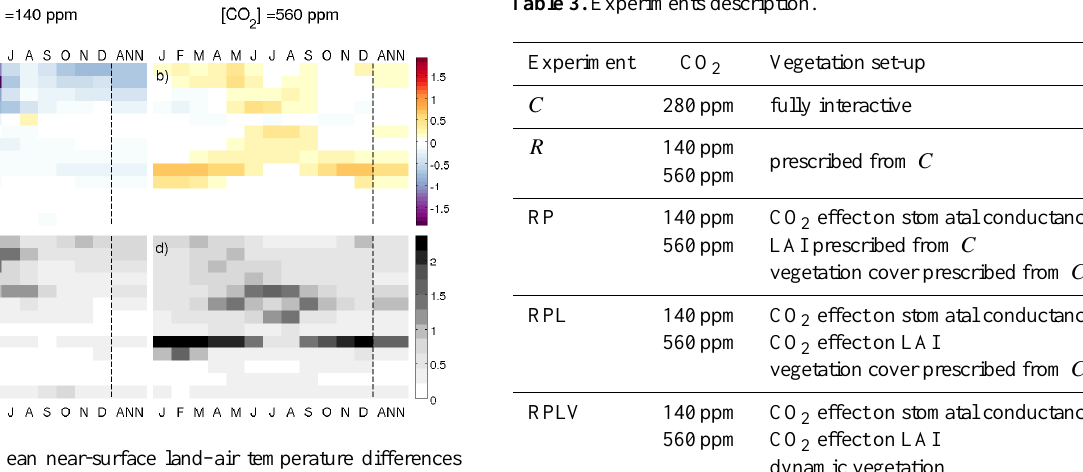
Fig. 9. Zonal mean near-surface land–air temperature differences between fully interactive (RPLV) and fixed ( R ) vegetation runs as a function of latitude and season for experiments with 140ppm (left) and 560ppm (right). Shown are the median (top) and the 5–95 per- centile range (bottom) of the ensemble. Annual mean zonal values are also shown on the right of each panel.